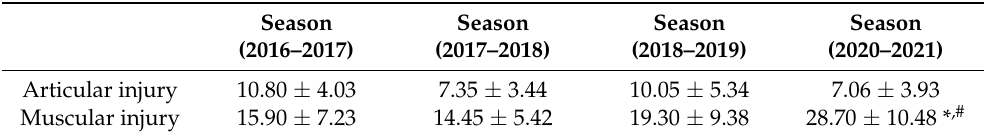
to average articular and muscular number of injuries of all Serie A teams. Data are presented as mean difference and 95% confidence interval of the Table 4. Comparisons between Player Short Positivity (n = 35) and Player Long Positivity (n = 35) using the median-split technique for days of positivity. Values are given as mean ± SD (* p = 0.0014). PSP PLP